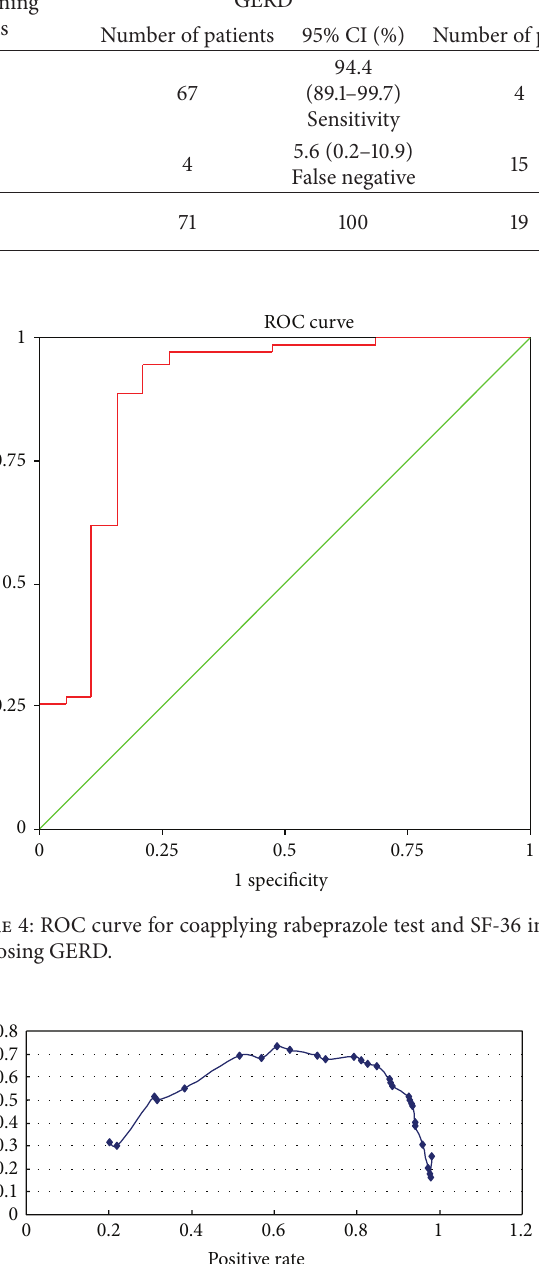
Table 7: Sensitivity and specificity of the rabeprazole test combined with SF-36 in diagnosing GERD when 𝑃 = 0.606 . Screening